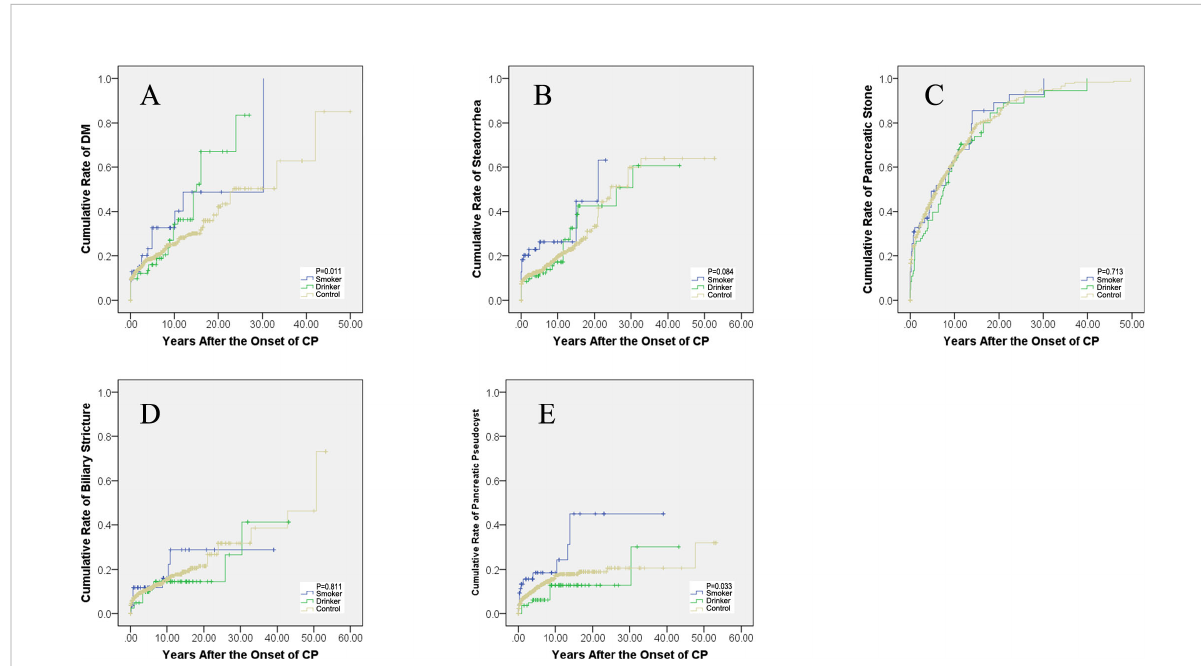
FIGURE 2 Cumulative rates after the onset of CP. (A) The cumulative rates of diabetes mellitus. (B) Cumulative rates of steatorrhea. (C) Cumulative rates of pancreatic stone. (D) Cumulative rates of biliary stricture. (E) Cumulative rates of pancreatic pseudocysts. CP, chronic pancreatitis; DM, diabetes